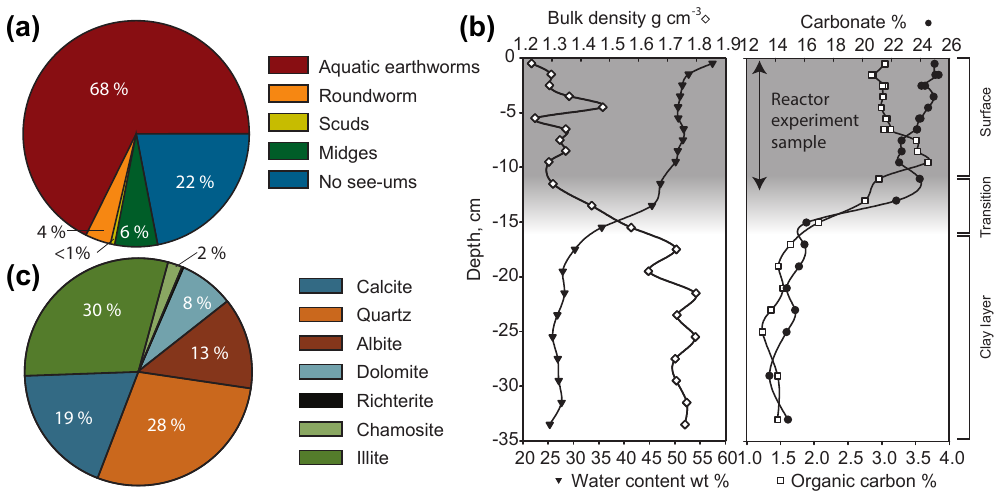
Figure 2. (a) Proportions of bioturbating macro-invertebrates identified in the top 18cm. (b) Depth profiles of sampled sediment, water content weight % (inverted black triangles), bulk density (white diamonds) OM % (white squares) and carbonate % (black circles). (c) Min- eralogical composition of sediments from the zone of bioturbation determined by XRD (top